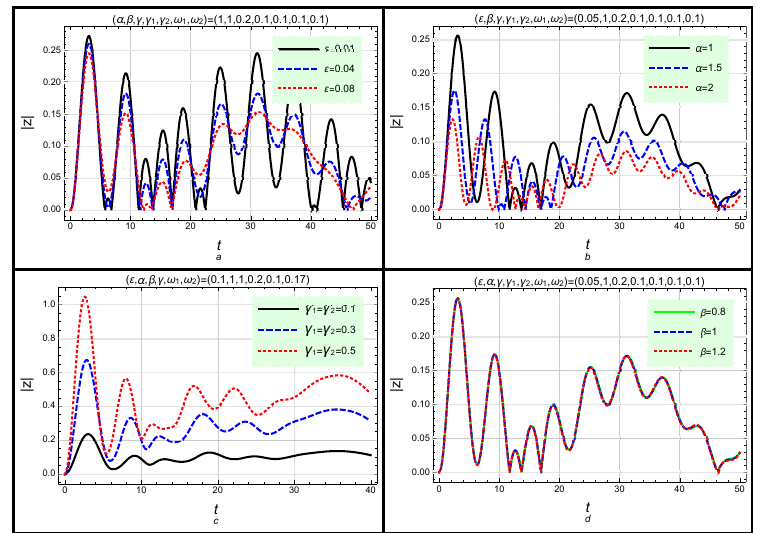
Fig.6 Figure 6. The impacts of the coefficients ( a ) ε , ( b ) α , ( c ) ( γ and damped CDO (I) (3) according to the analytic approximation